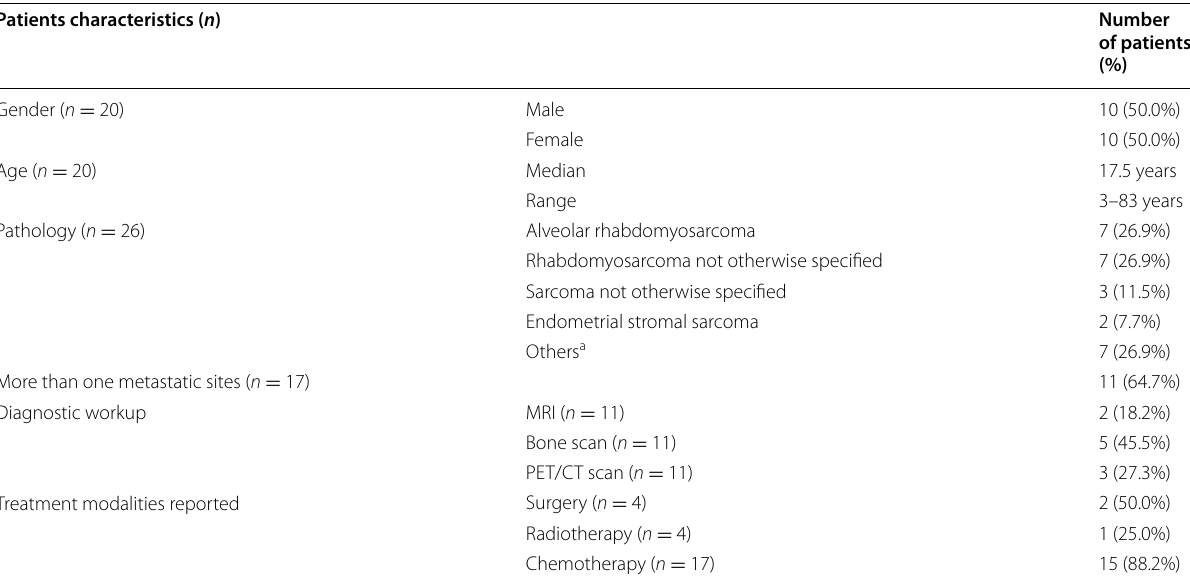
a Others include dermatofibrosarcoma protuberans ( n Ewing’s sarcoma ( n